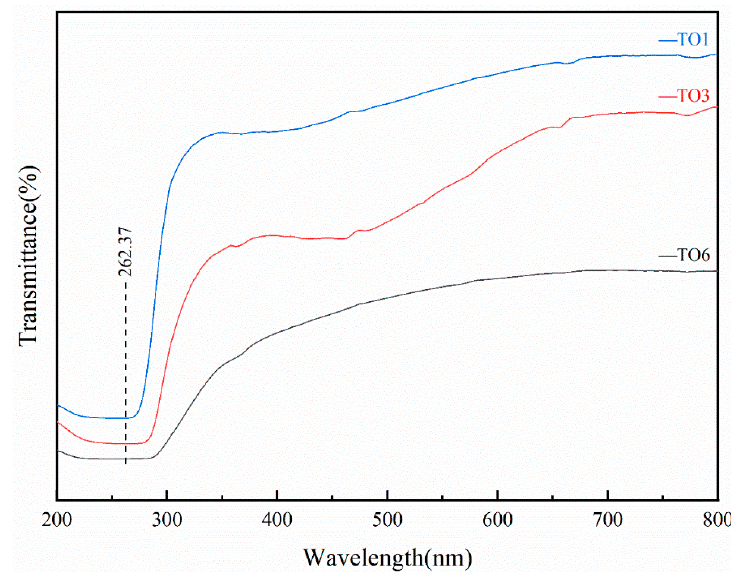
Figure 6. The UV-VIS spectra of yellow topaz